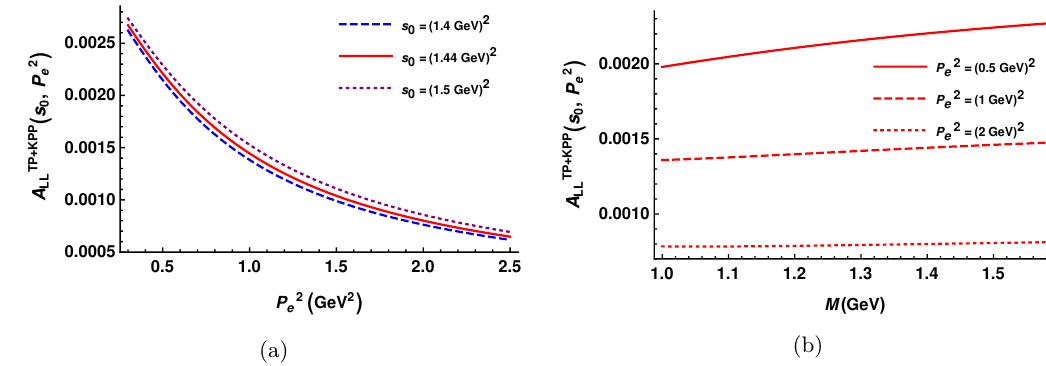
and F KPP LL LL = 0